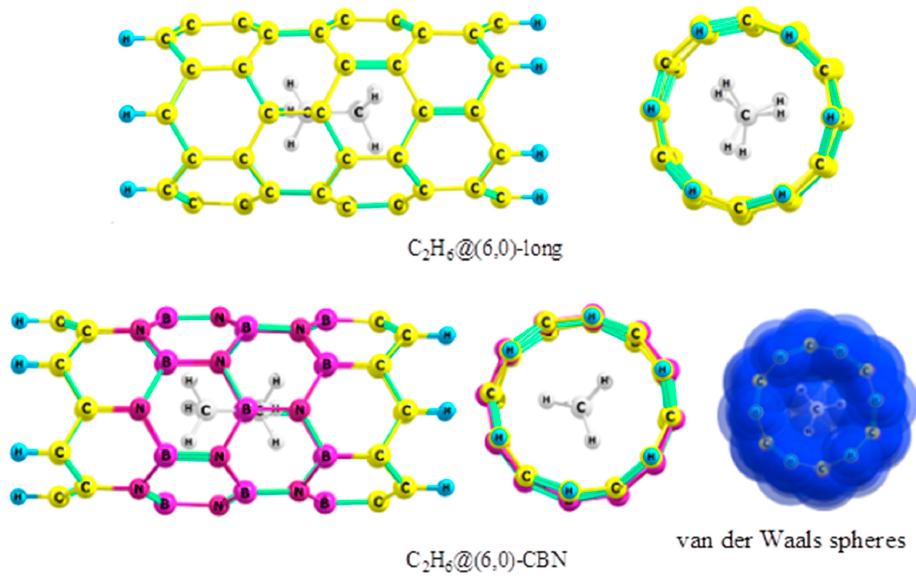
Figure 2. Nanoclusters C 2 H 6 @SWCNTs. Adapted with modification [126,127].